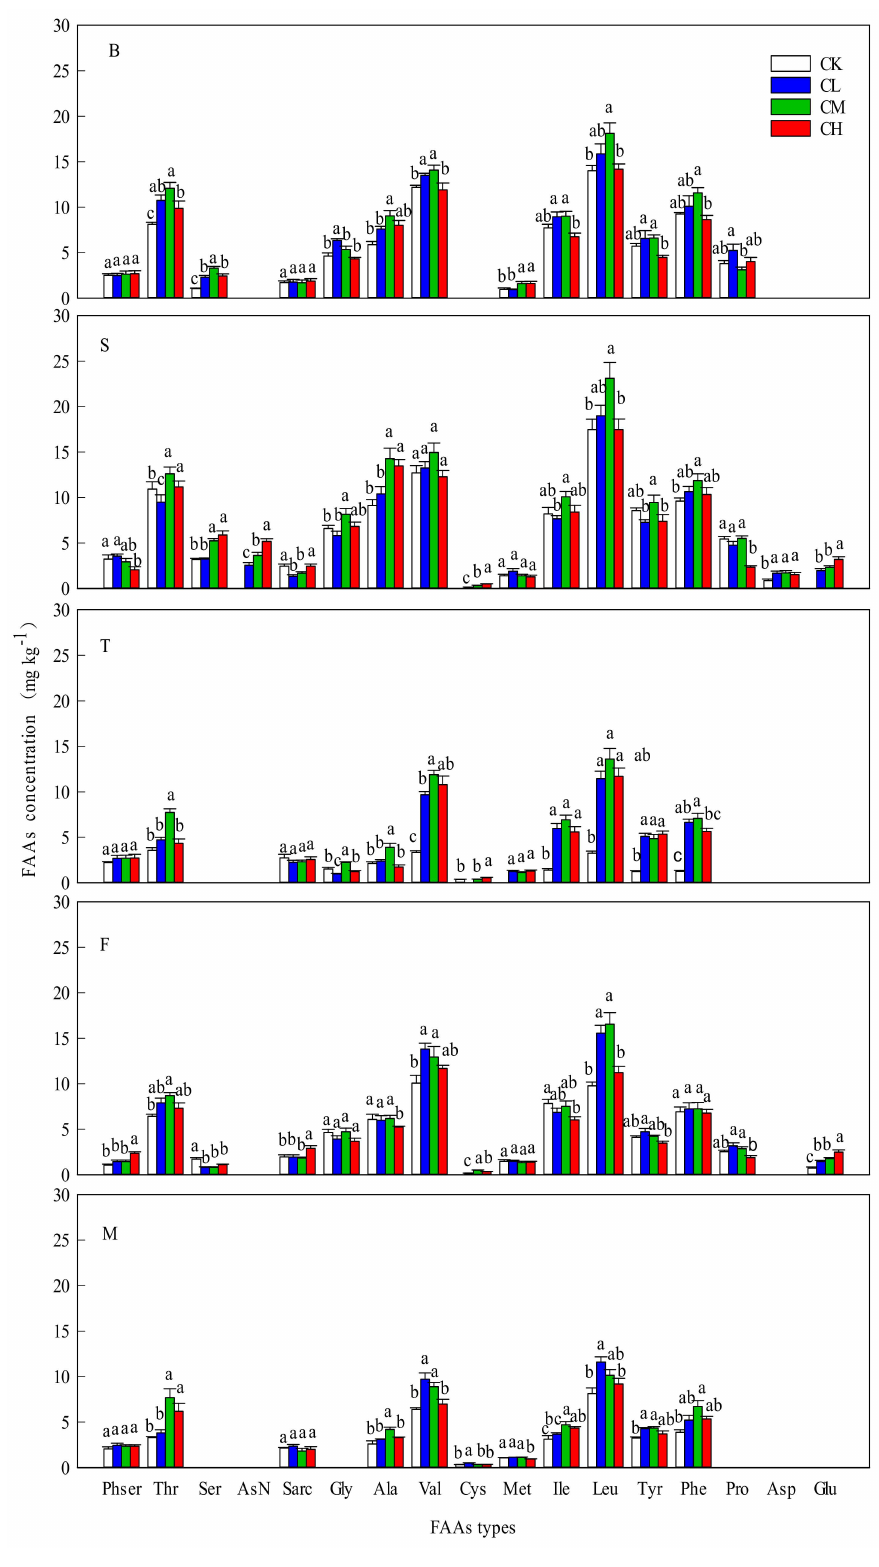
Figure 3. Dynamics of soil FAAs composition under different fertilization treatments during the rice growth stage. Note: CK: chemical fertilizer, CL: the low amount of CMV, CM: the medium amount of CMV, CH: the high amount of CMV, B: background soil, S: seedling stage, T: tillering stage, F: flowering stage, M: maturity stage. The error line indicates a standard error (n = 3). Lowercase letters represent significant differences between treatments ( p < 0.05, Duncan